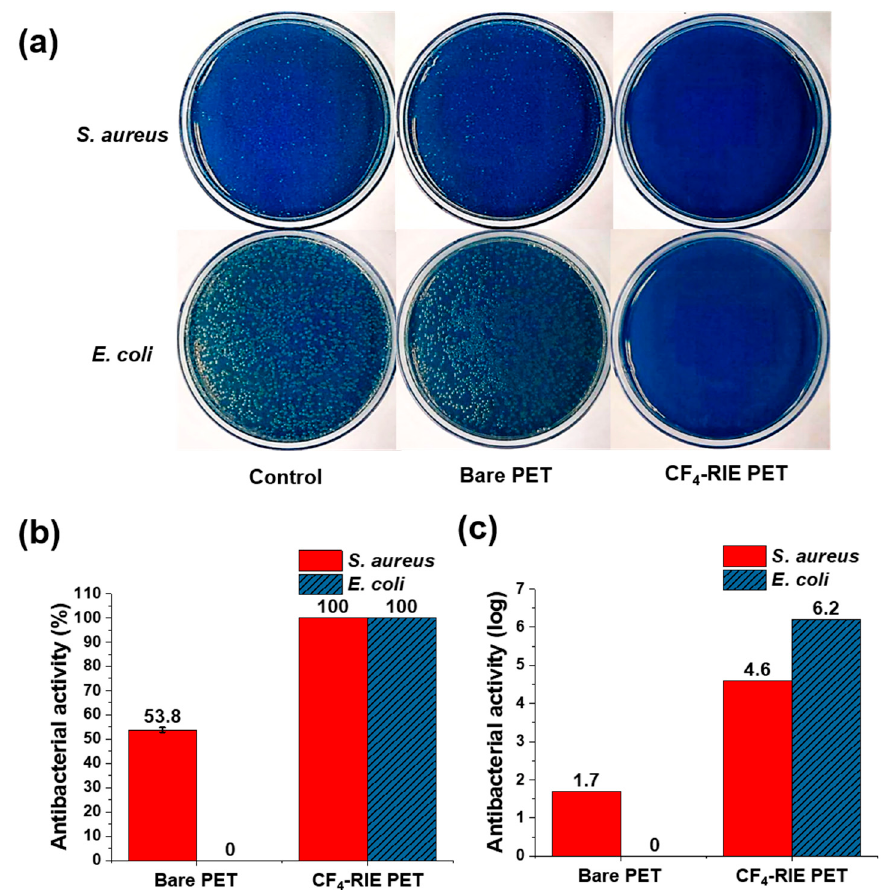
Figure 4. ( a ) Top-view photos of incubated agar plates and ( b , c ) antibacterial activity of bare PET and CF 4 -RIE PET. The initial bacteria density on the sample was 1.7 × 10 4 CFU / cm 2 . The contact time between the sample and bacteria-containing inoculum was 24 h.